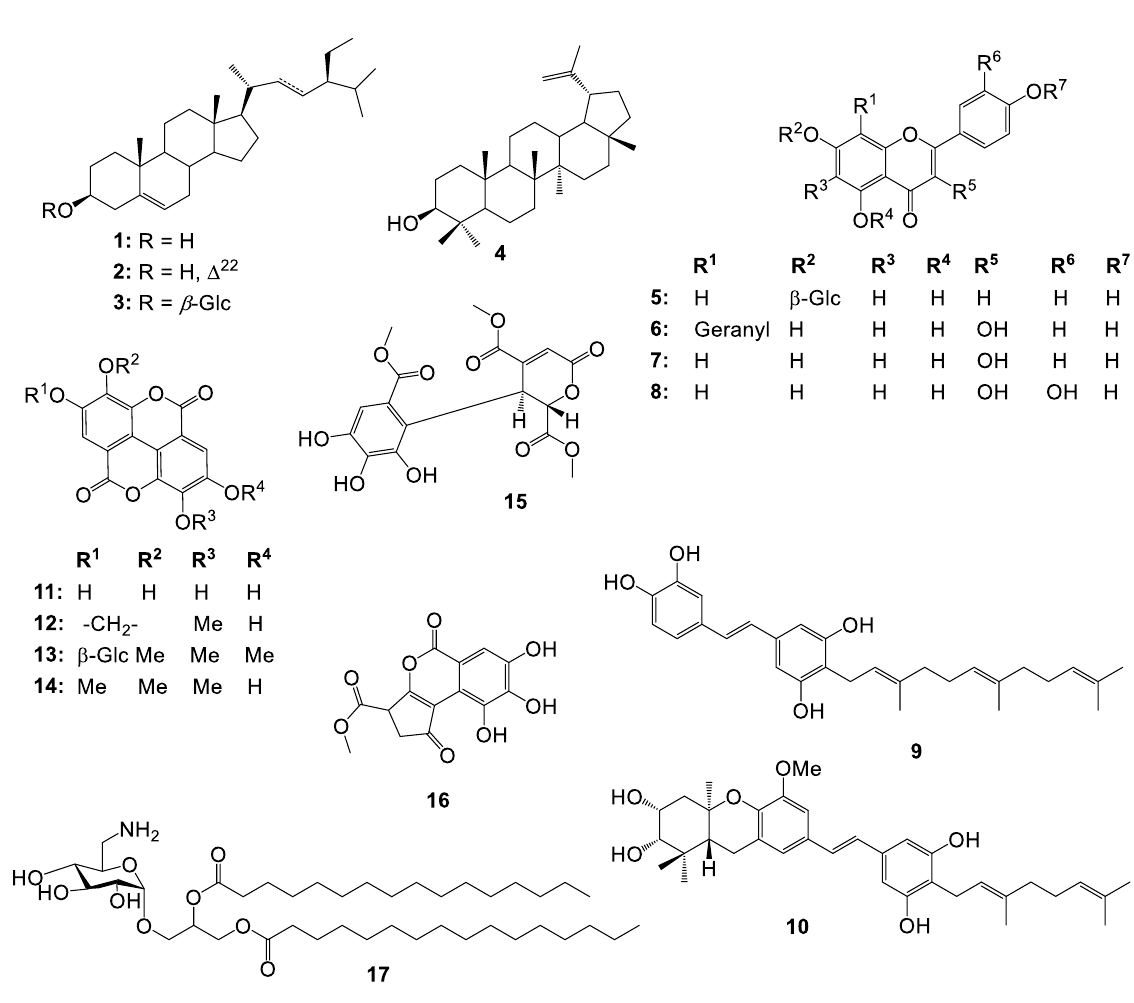
Figure 1. Structures of the isolated compounds ( 1−17 ) from M. occidentalis .